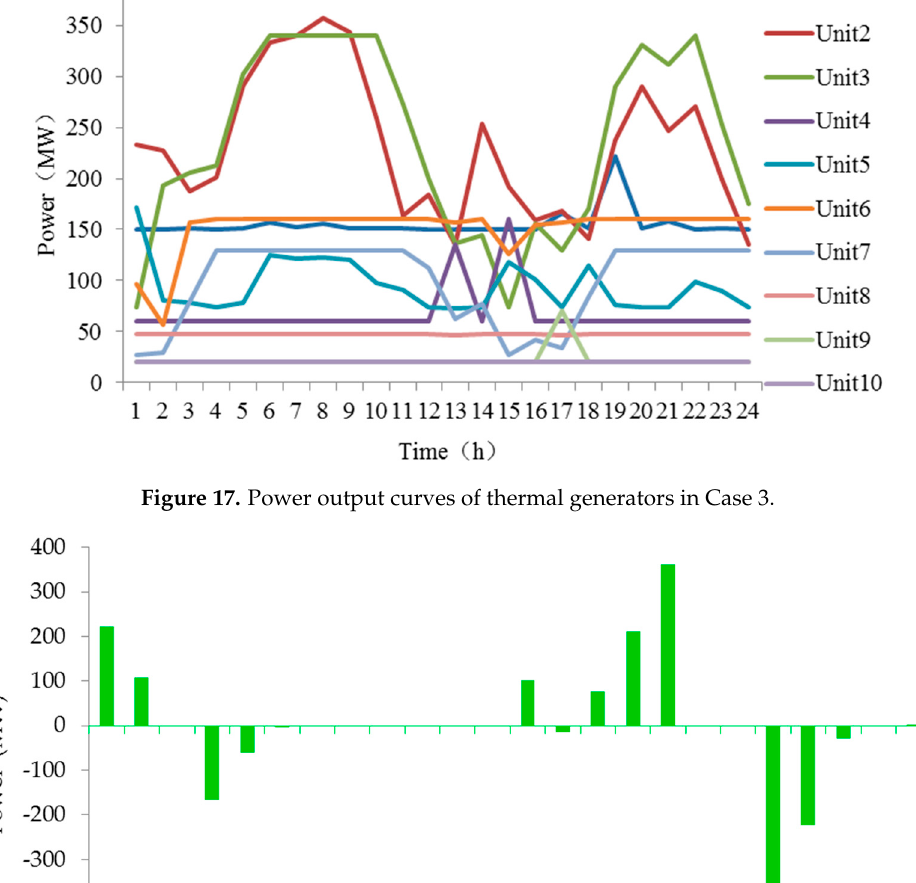
Figure 16. Power output comparisons of pumped storage in Case 1 and Case 2.